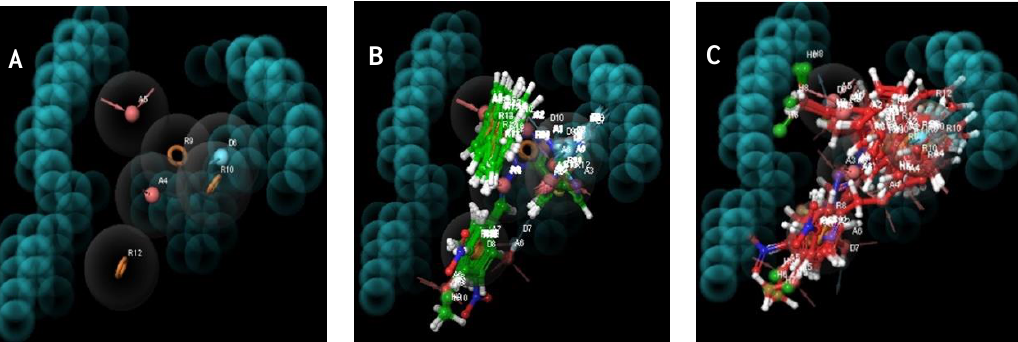
Figure 4. ( A ) The best generated pharmacophore model with the features considered Hydrogen bond acceptor ( A ), Hydrophobic group (H), Aromatic ring (R), ( B ) the alignment of the highly active compounds ( 11a–d , 12a–d ), and ( C ) the alignment of the less active compounds ( 9a–d , 10a–d ).